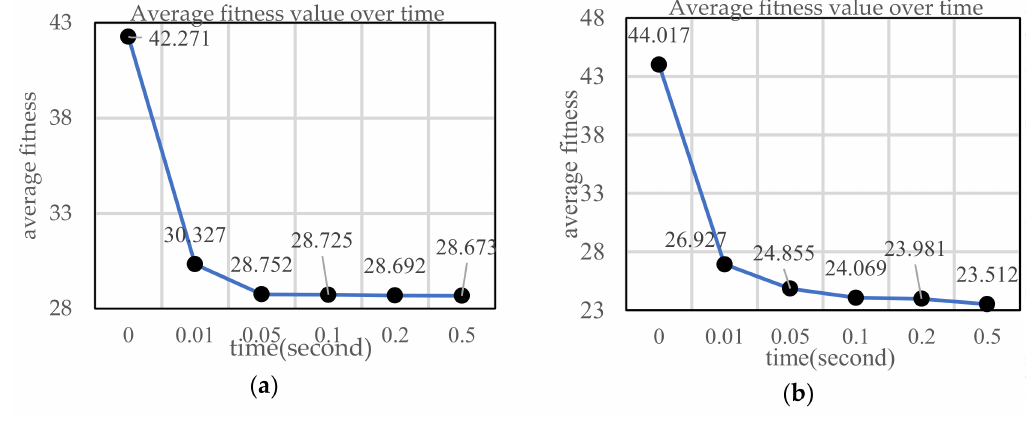
Figure 22. Rapid convergence of proposed method in environments. ( a ) Environment 1; ( b ) Environment